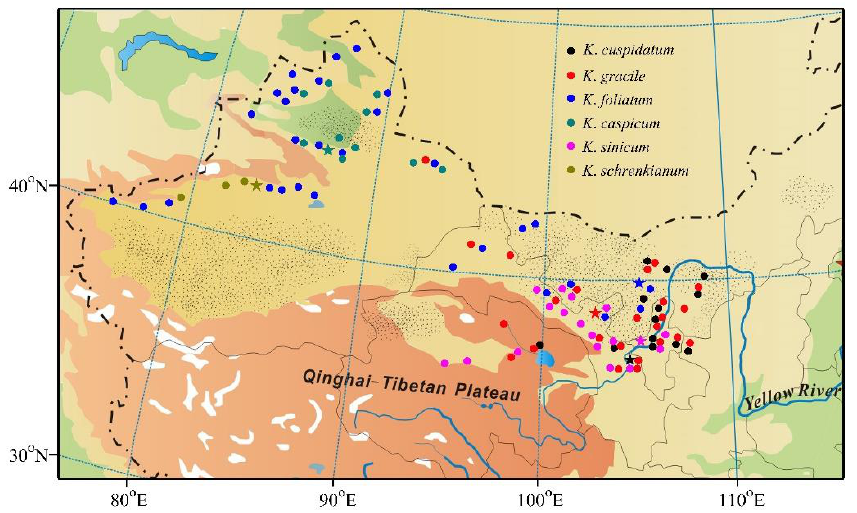
Figure 1. Map showing soil sampling sites in areas occupied by the six Kalidium species. Stars indicate seed sampling sites.